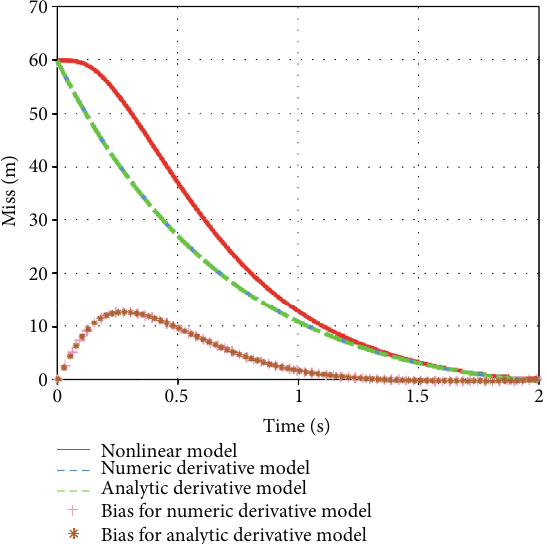
Figure 11: Comparison of the miss distance index between three